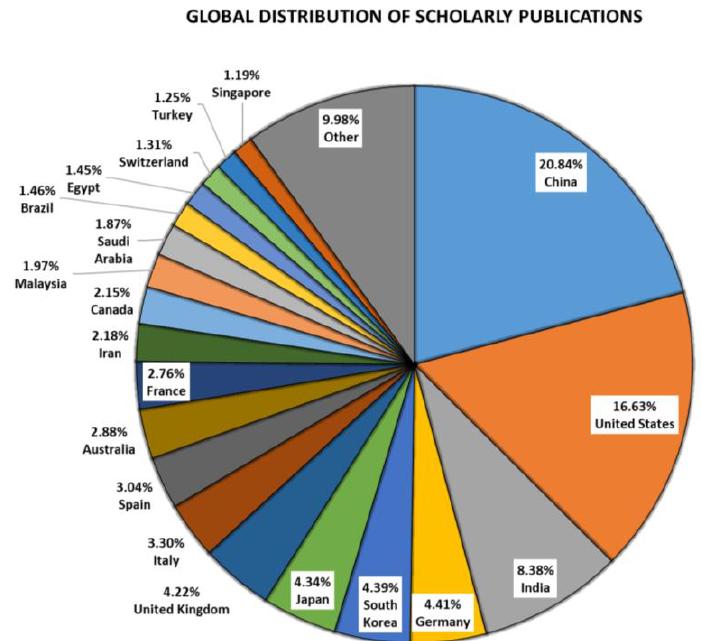
Figure 6. Proportion of publication classification by country.